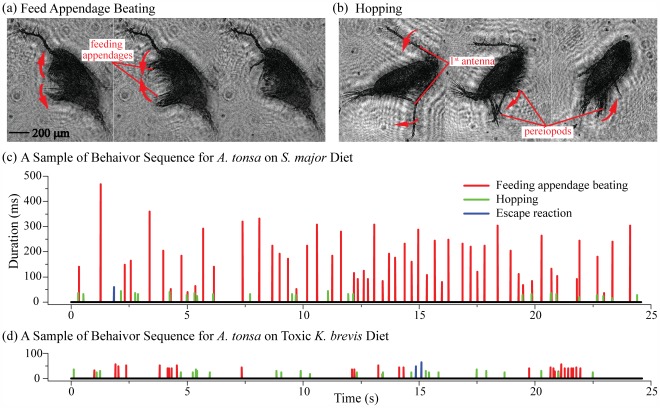
Sample holographic images and time series of Acartia tonsa behavior.Sample sequences of reconstructed images showing an A. tonsa performing: (a) feeding appendage beating, i.e. periodic movement of feeding appendages which include the 2nd antennae, 1st maxillae, 2nd maxillae, mandibular palps and maxillipeds, shown at 4 millisecond (ms) interval, and (b) hopping involving a quick backward movement of both the 1st antenna and pereiopods, shown at 8 ms interval. Escape reaction is characterized by repetitive motion of the pereiopods and retraction of the 1st antennae, much like the last snapshot of the hopping sequence. (c) & (d) Samples of time series tracking the behaviors of a single A. tonsa when exposed to:(c) a mono-algal diet of S. major, and (d) a mono-algal diet of K. brevis 2228. For each event, the color and height of bars specifies the behavior and its duration respectively.